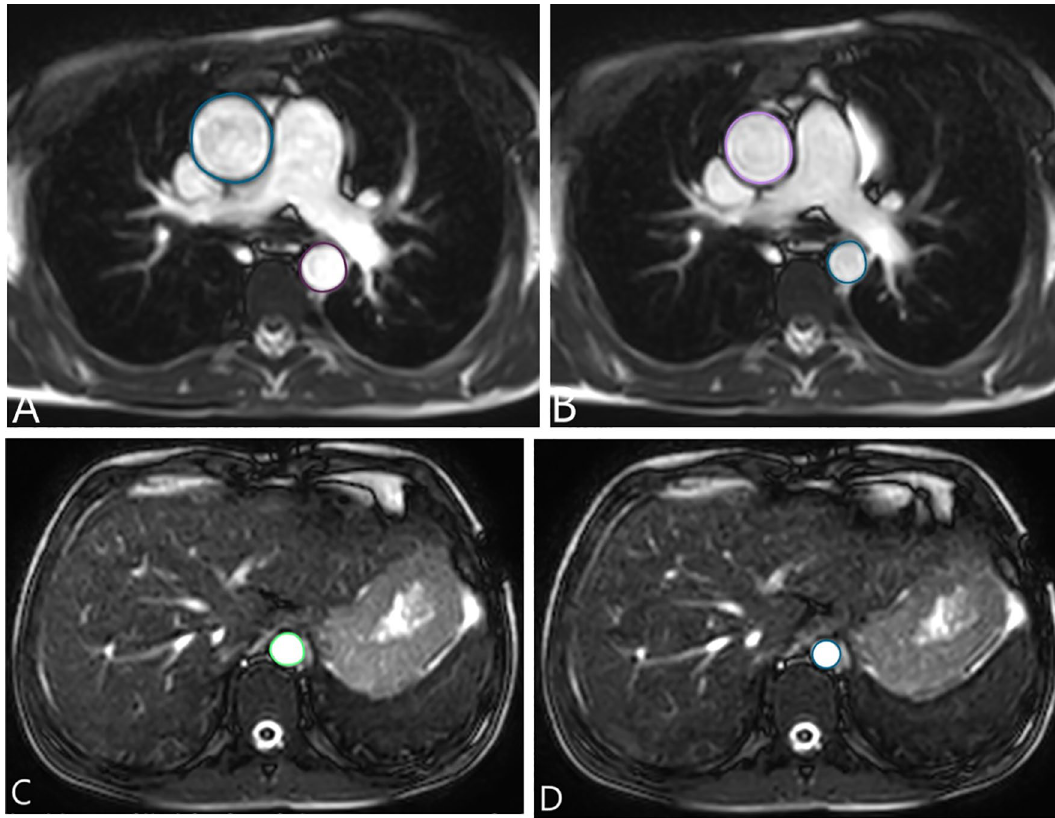
Figure 1. Axial cine SSFP images show measurement of maximal and minimal aortic area of ascending aorta ( A,B ), proximal descending aorta ( A,B ) and aorta at diaphragm ( C,D ). Patients n = 30 Mean ±